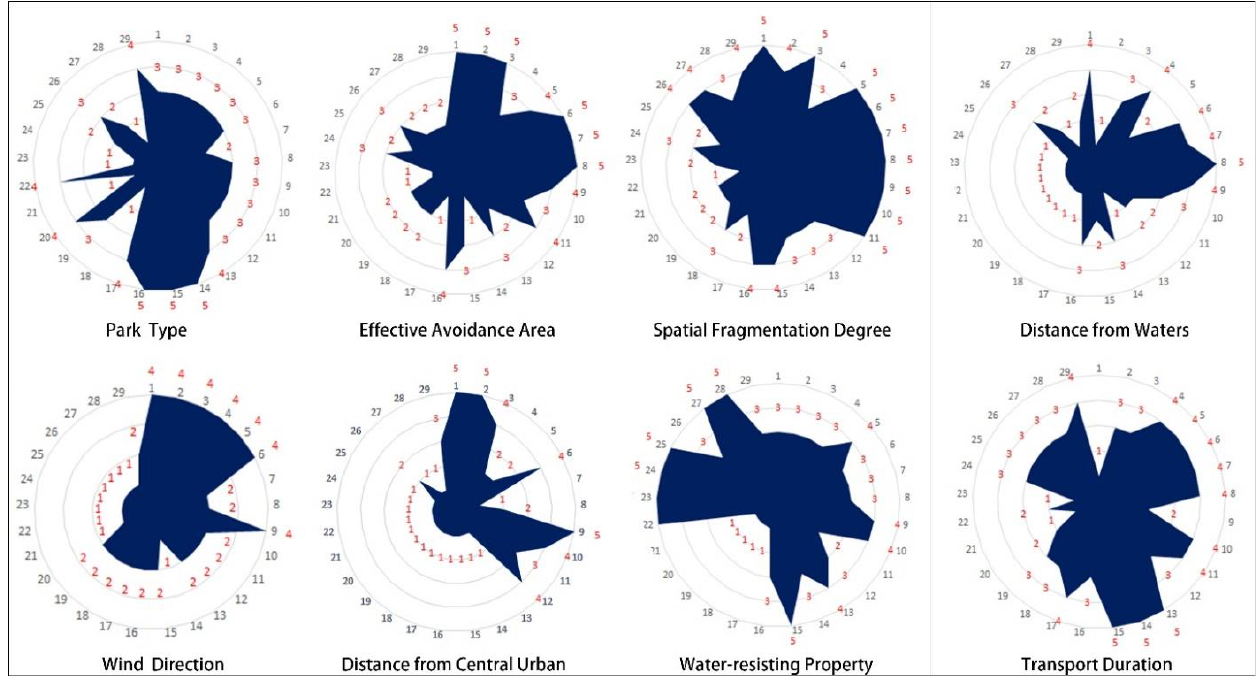
Figure 5. Scores of the impact factors.